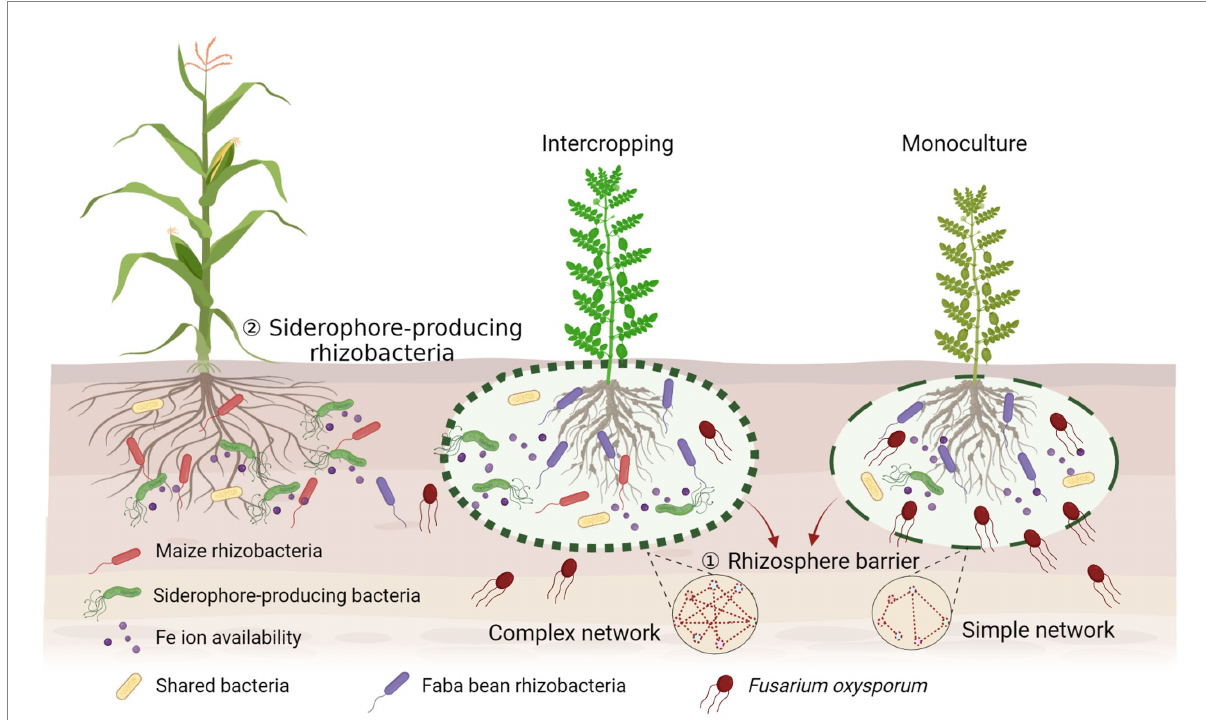
FIGURE 7 Conceptual model displaying the potential mechanisms of suppression of the fungal pathogen in the intercropping rhizosphere by building up a complex bacterial network to form the rhizosphere barrier and simulating more siderophore-producing bacteria to compete with pathogenic fungi for iron. Created with